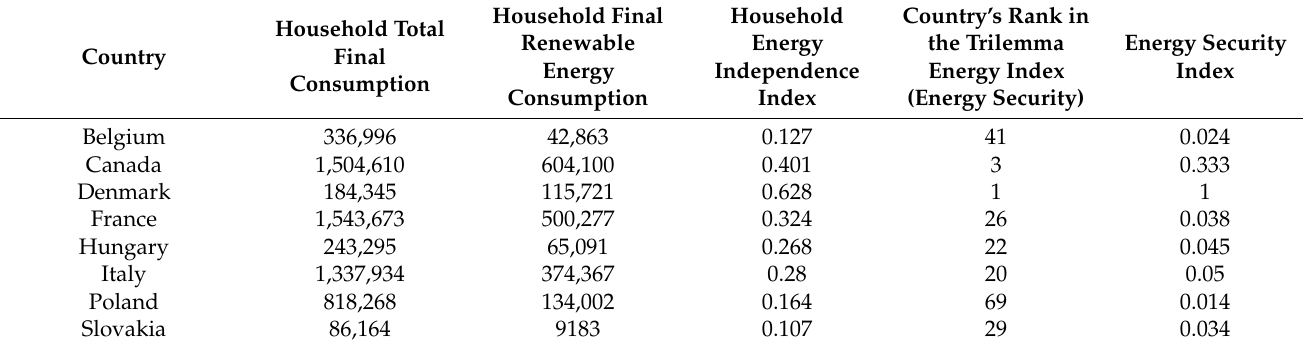
Table 1. Initial data for determining the relationship between the level of energy security and household energy independence.